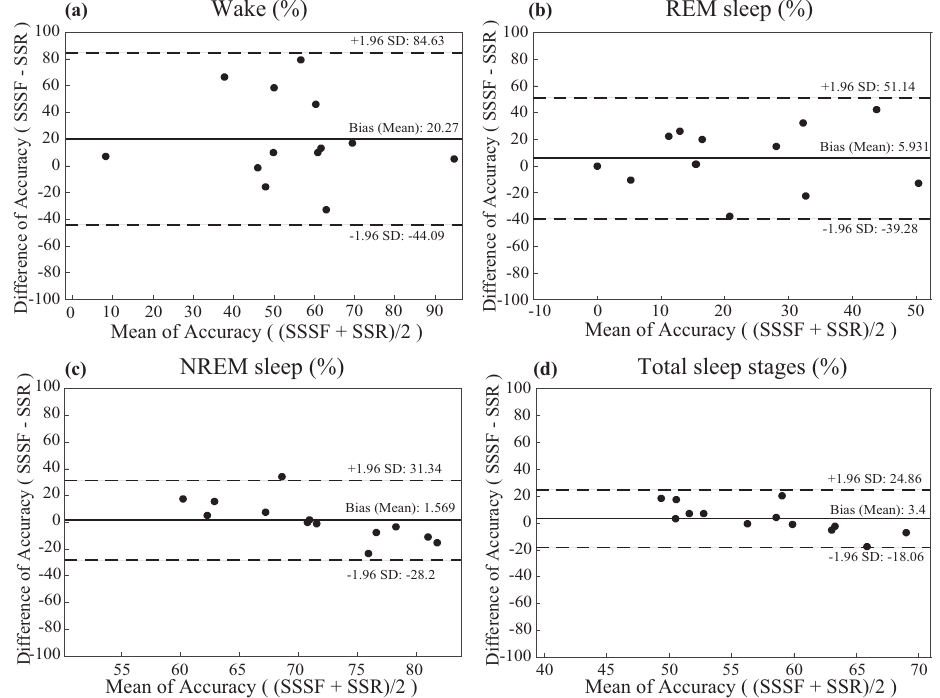
Figure 9. The Bland–Altman plot of: ( a ) wake; ( b ) REM sleep; ( c ) NREM sleep; ( d ) total sleep stage classification accuracy comparing the performance of sleep stages via the sensor-fusion algorithm (SSSF) and the sleep stages via ResMed S+ (SSR). The means of the accuracy of SSSF and SSR are on the x axis, and the differences (SSSF-SSR) are on the y axis. Indicated in the right are the values, the bias (mean) ± the standard deviation (SD). The bold line represents the mean (bias) difference in the accuracies, and the dotted lines represent the limits of agreement (from − 1.96 to +1.96 standard deviations with respect to the